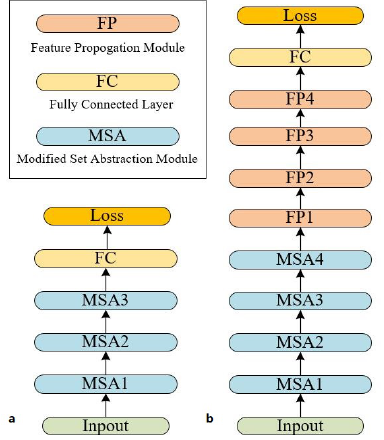
Figure 3. Proposed network architecture for classification ( a ) and segmentation ( b ) tasks. Where the part stacked by the MSA module is the front-end of the network model, and the other part is the